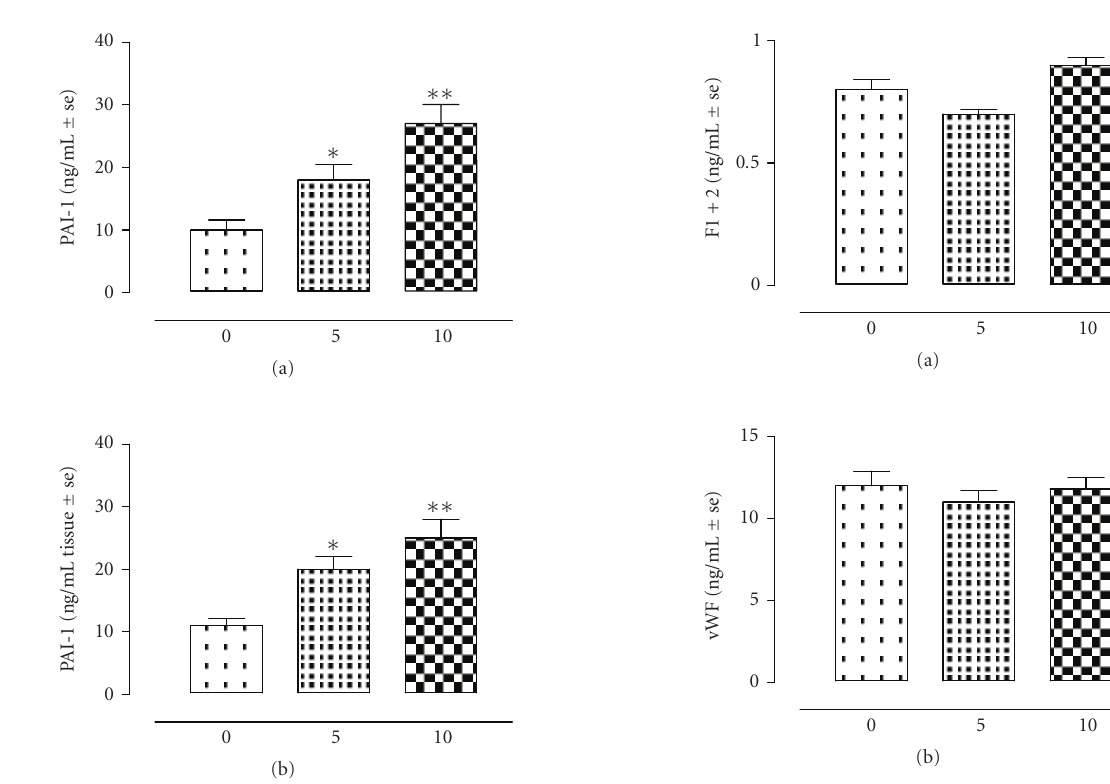
Figure 2: PAI-1 levels in rats ( n = 8) subjected to experimental peritoneal adhesion development. The time is expressed in days.